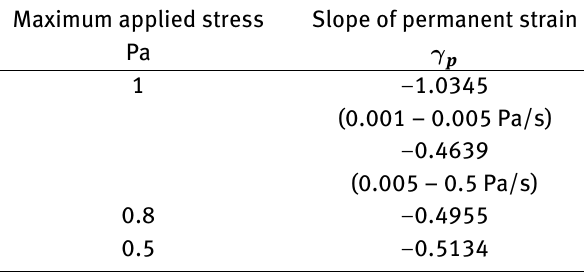
Table 1: Slope of the permanent strain for α -gel O/W emulsion. The slope depends on the stress-ramp rate and the maximum applied stress. The maximum applied stress 0.8 Pa and 0.5 Pa does not show the slope of − 1, unlike Newtonian fluids. The slope in 1.0 Pa can be divided in two regions (0.001–0.005 Pa/s, 0.005–0.5 Pa/s). The former shows the slope of − 1 like Newtonian fluids Maximum applied stress Slope of permanent strain Pa 𝛾 p